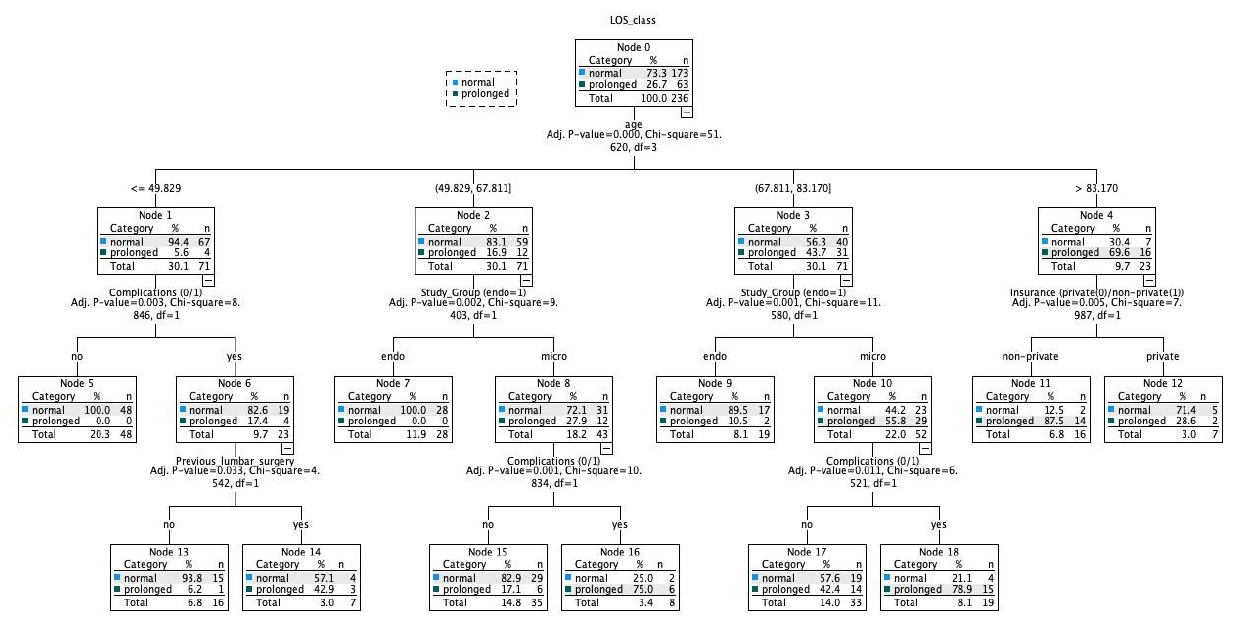
Figure 7. Decision tree with CHAID growing method. Five-fold cross-validation. Percent correct predictions with this algorithm: 84.7%.